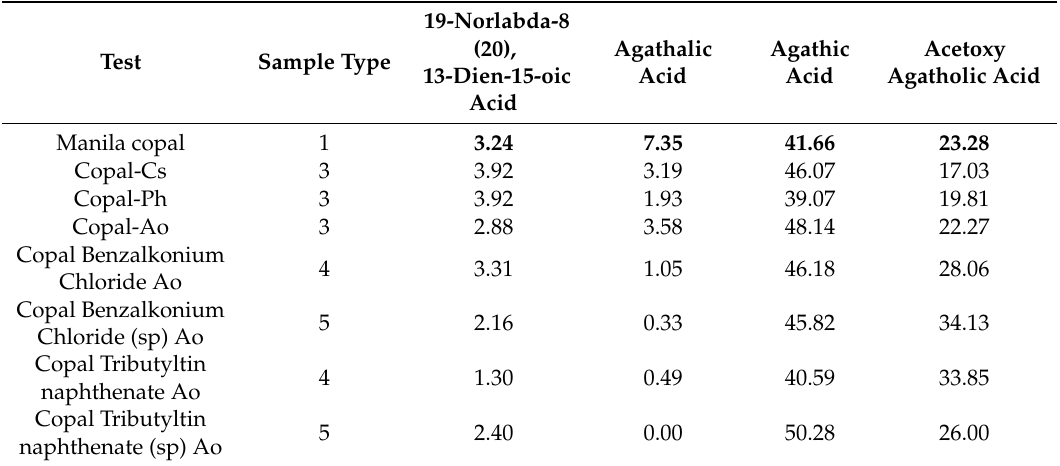
Figure 6. Microphotography (400 × ) showing fungal growth of ( a ) P. chrysogenum (sandarac) and ( c ) C. sitophila (Manila copal) after 5 days of incubation, images ( b ) and ( d ) show samples of sandarac treated with tributyltin naphthenate (mixed) and benzalkonium Chloride (mixed) in which no fungal growth was observed after the incubation period. Table 4. GC-MS analysis ( p < 0.05 in all cases) of the diterpenes free of Manila copal and the samples inoculated with microorganisms (values expressed in Ni